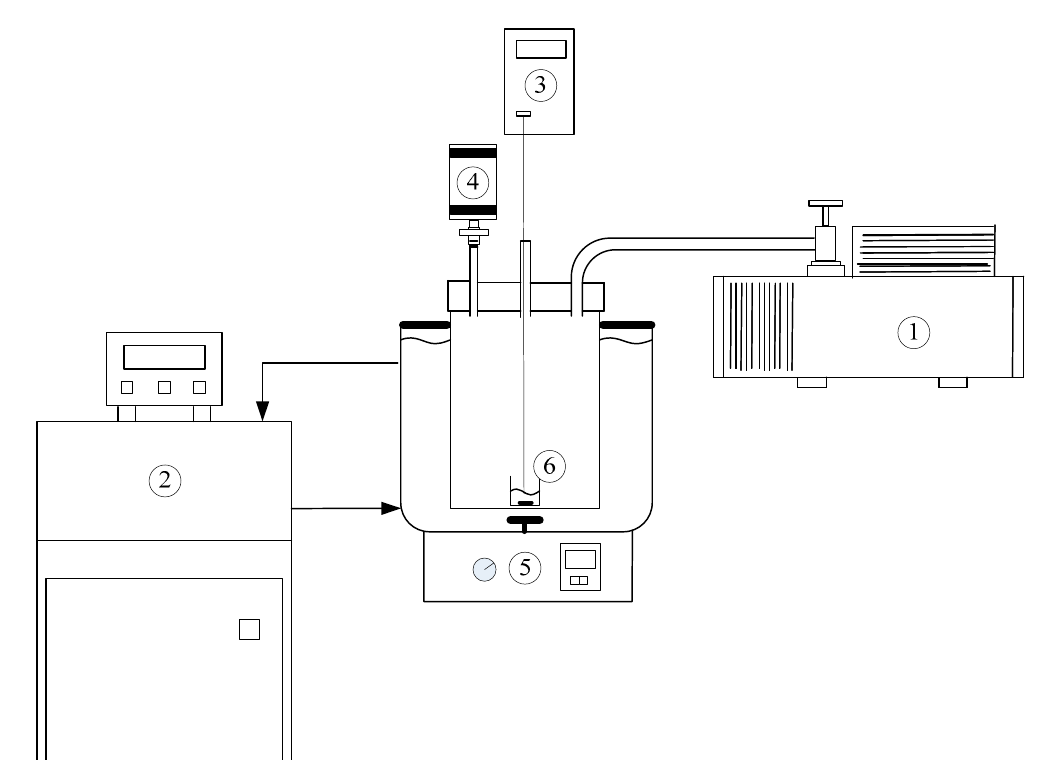
Figure 3. Schematic diagram of the experimental apparatus for the SC operation with the features: (1) Mechanical pump, (2) constant temperature bath, (3) thermocouple, (4) pressure gauge, (5) magnetic stirrer operated at 70 rpm, (6) 5-mL sample container in a 1.5-L chamber. R -phenylglycinol (purity >98%) and S -phenylglycinol (purity >98%) were purchased from